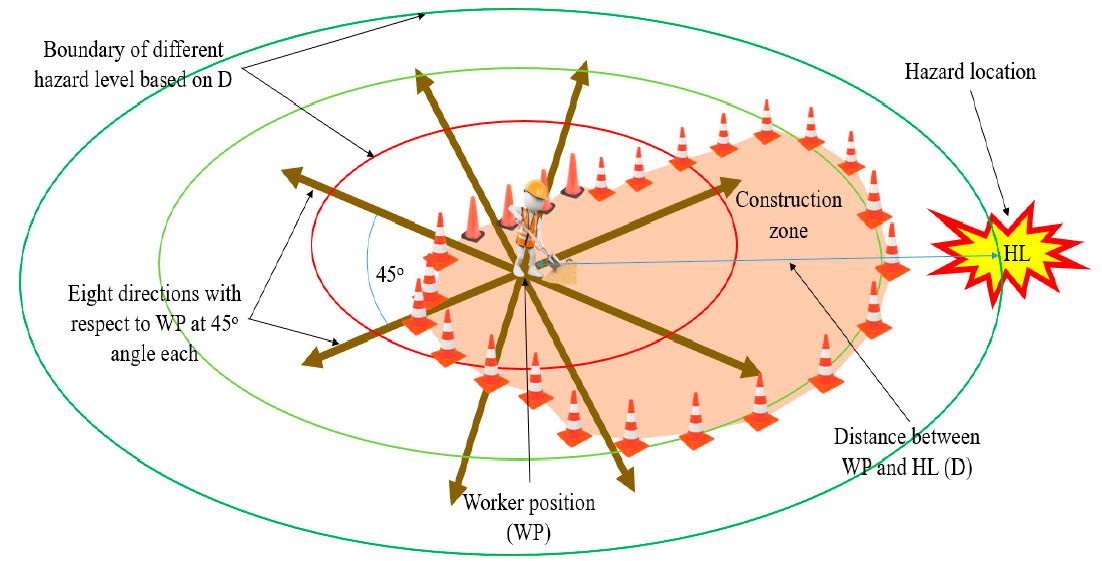
Figure 3. Hazard location information.